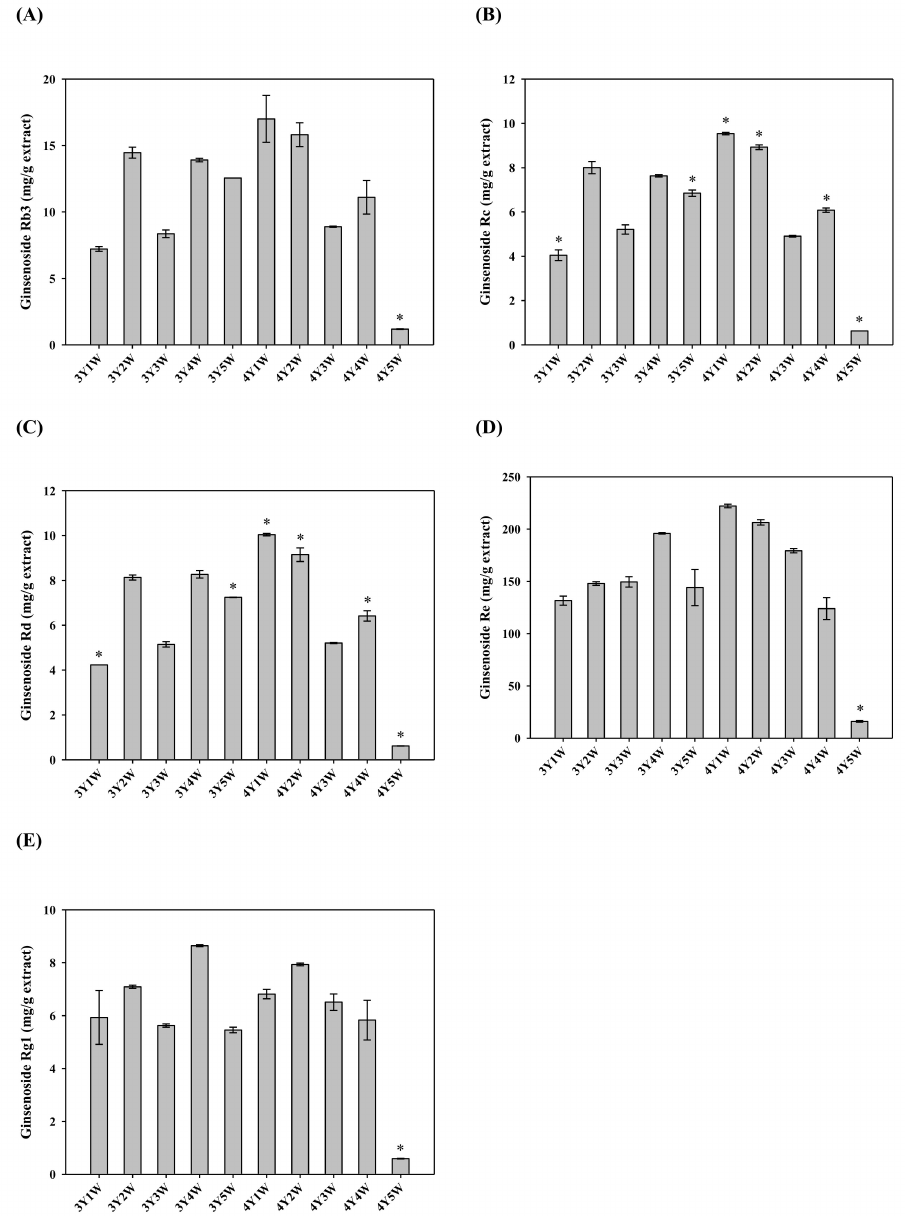
Figure 6. Contents of ginsenosides Rb3 ( A ), Rc ( B ), Rd ( C ), Re ( D ), and Rg1 ( E ) in ginseng berry extracts harvested at various time points. Rectangular bars and their error bars represent means and standard deviations, respectively ( n = 3). The ‘ m Y n W’ on the x-axis means m -year-old ginseng berry harvested in the n th week of July. *, significantly di ff erent from other